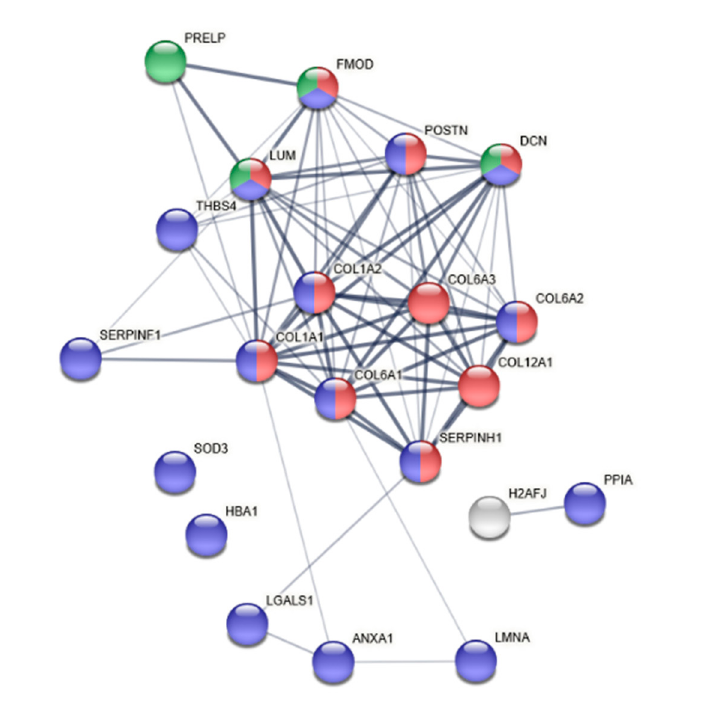
Figure 3. Pathway analysis of altered proteins between FDP and PER. Each protein is represented by a colored node, and protein–protein interaction is represented by an edge visualized as a line. Higher combined confidence scores are represented by thicker lines/edges. The significant protein–protein interactions enrichment (PPI) ( p ‐ value < 1.0 × 10 − 16 ) identified three biological processes that the proteins were involved in; extracellular matrix organization (red), response to chemical (blue), and glycosaminoglycan catabolic process (green).